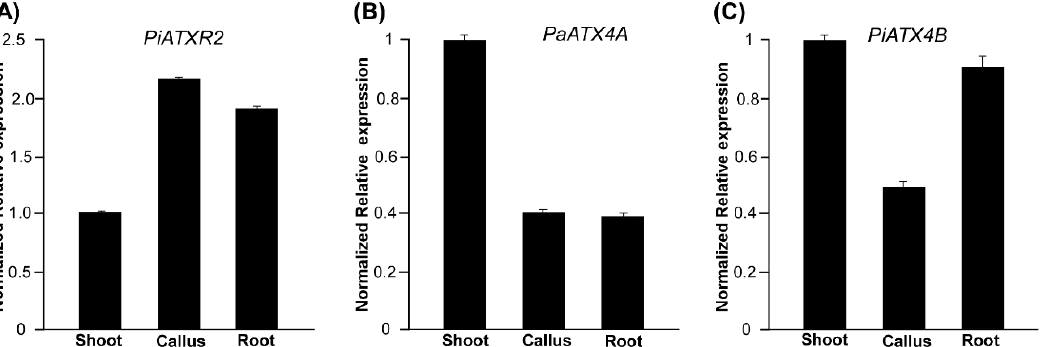
Figure 4. Transcriptional mRNA expression profiles of genes that act as molecular signatures of the different developmental processes of P . × hybrida cv. Madness Midnight. Expression of genes ( A ) ATXR2 , ( B ) PaATX4A from P. axillaris , and ( C ) PiATX4B from P. inflata in developmental stages of callus, shoot, and root in Petunia protoplast-derived tissue culture. Expression levels of genes were normalized relative to the elongation factor 1 gene. Transcriptional fold changes in shoot tissues (control) were set to level 1 for determining the fold changes in other tissues.